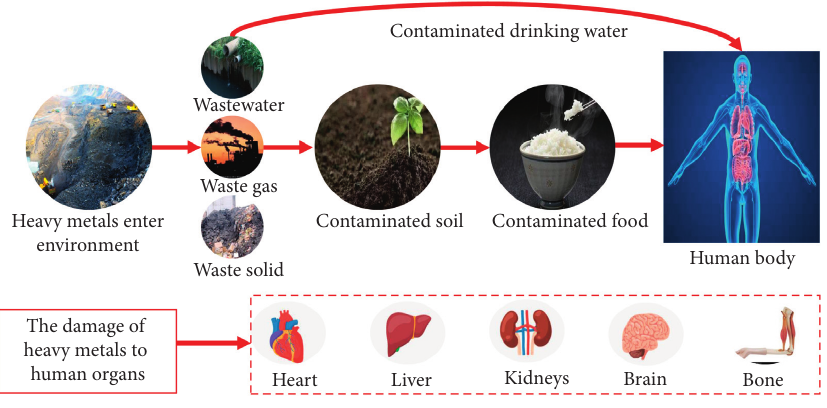
Figure 1: Sources of heavy metals and its hazard to the human body.